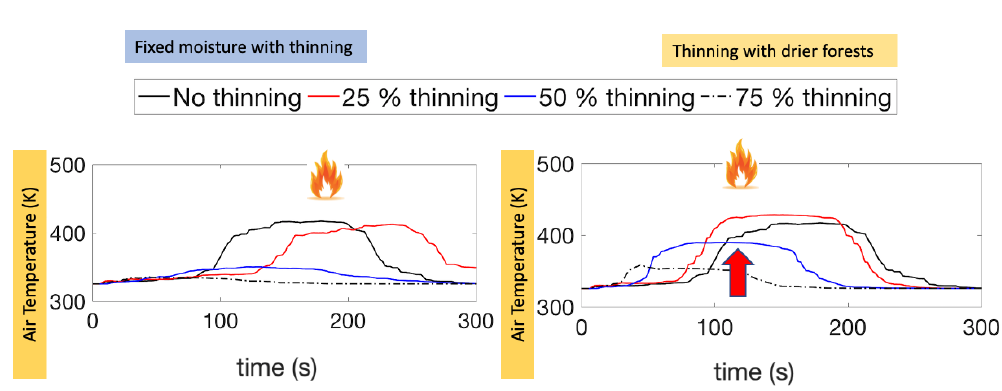
Figure 5. Air temperature recorded at 15 level at domain centre as the fire propagates. Left panel shows the reference case and the three thinning cases with no change of canopy fuel moisture. Right panel shows the reference cases and the 3 thinning cases with lower canopy fuel moisture. The arrival of the fire front is shown with a fire symbol.